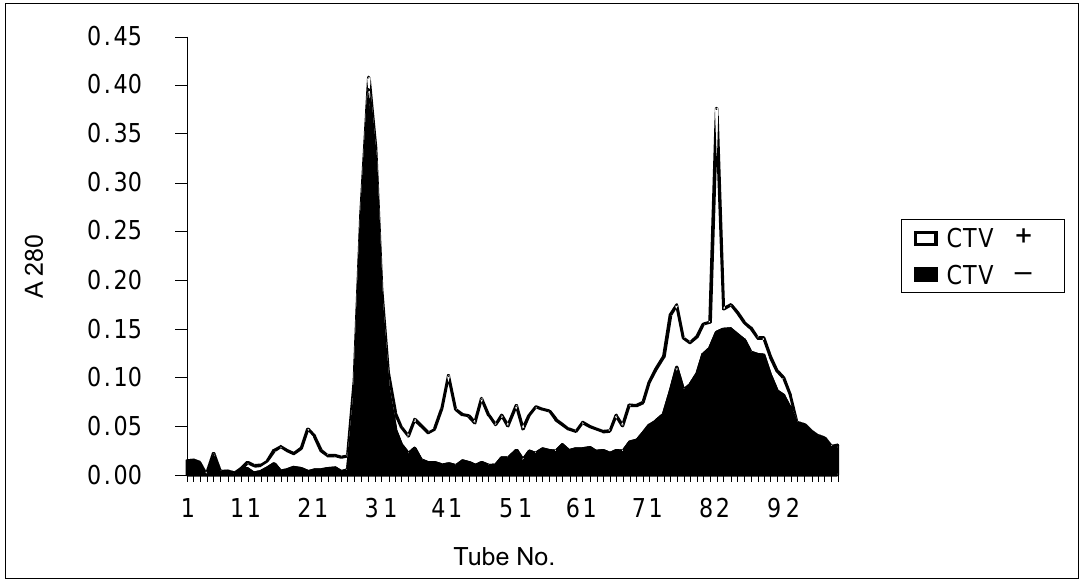
Fig. 1. UV absorption spectrum of partially purified virus preparation subjected Sephacryl 300 column chromatog- raphy (CTV+). Virus particles were present in fractions No. 26 and 36 which showed the highest absorbance. The control preparation (CTV-) show much lower absorbance